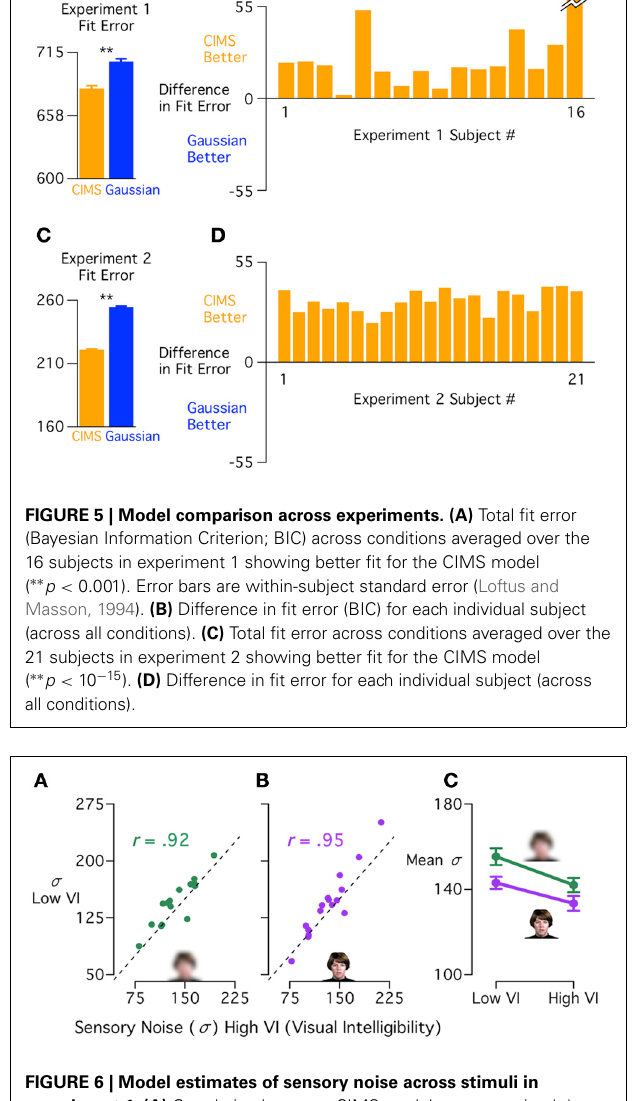
FIGURE 6 | Model estimates of sensory noise across stimuli in experiment 1. (A) Correlation between CIMS model sensory noise ( σ ) estimates for visual blurred words with high visual intelligibility (high VI) and low VI. Each symbol represents one subject, the dashed line indicates equal sensory noise between the two conditions. There was a strong positive correlation ( r = 0 . 92, p < 10 − 6 ). (B) Correlation between sensory noise estimates for visual reliable words with high and low VI ( r = 0 . 95, p < 10 − 7 ). (C) Mean sensory noise across subjects [ ± within-subject standard error of the mean (Loftus and Masson, 1994)] for visual blurred words (green line) and visual reliable words (purple line) with low VI (left) or high VI